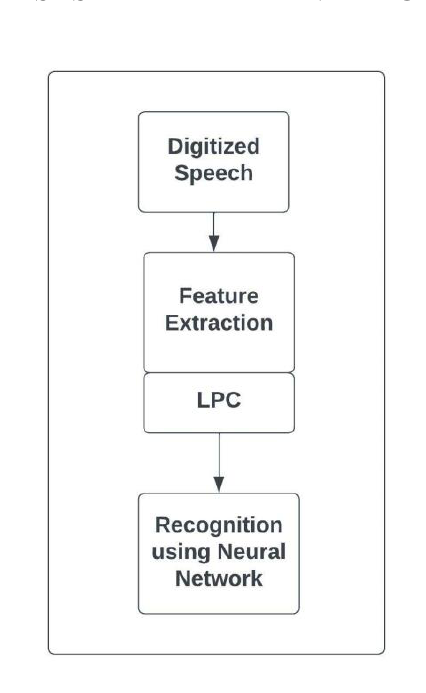
Fig. 2 Flow Diagram of Flow diagram of an Automatic Speech Recognition